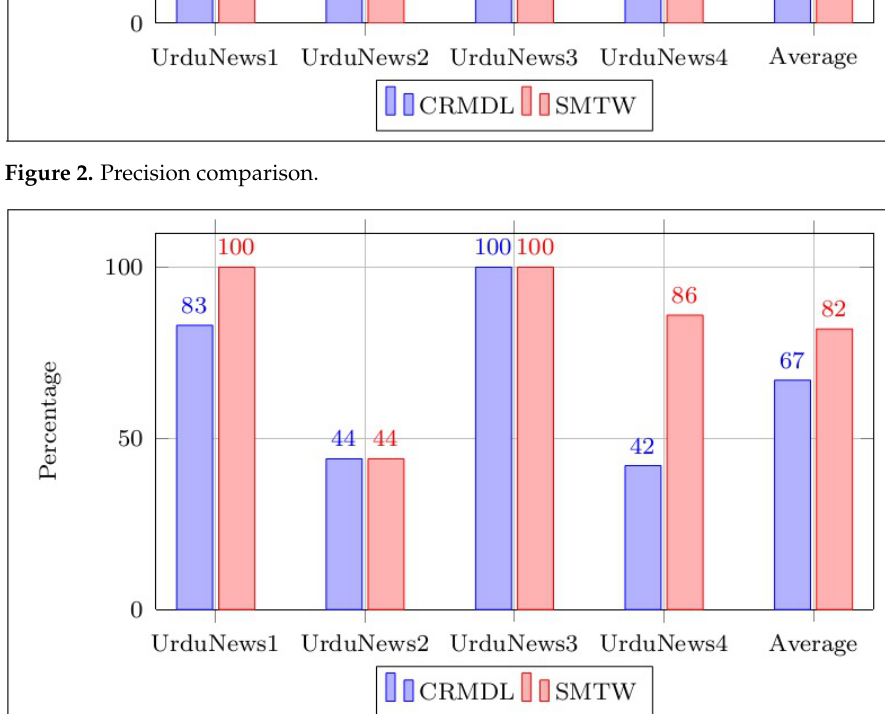
Figure 3. Recall